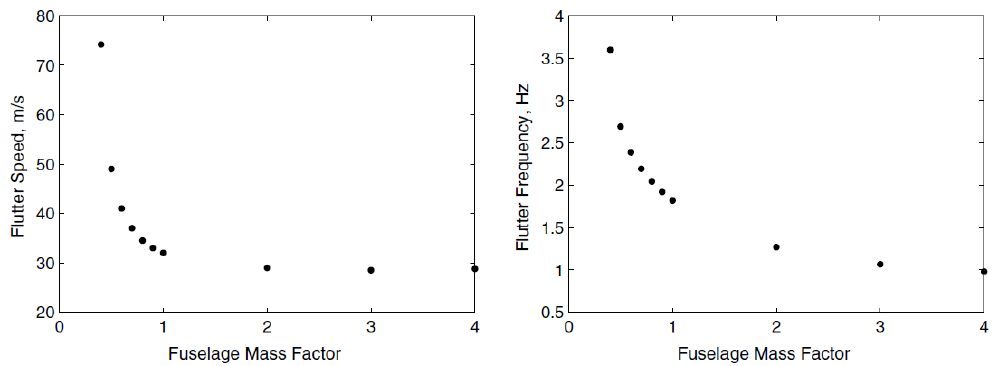
Figure 2. Flutter speed and frequency as a function of fuselage mass factor [7].